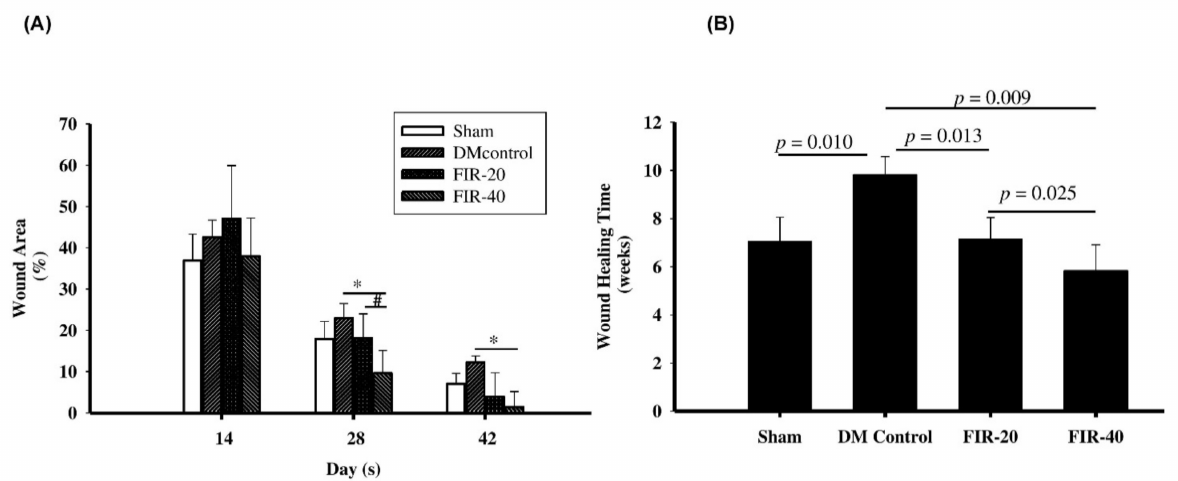
Figure 1. Far-infrared radiation (FIR) treatment in enhancing blood perfusion in the diabetic wound area. The blood perfusion in the wound area was detected by laser Doppler before (pre-FIR) and 1 h after the FIR (post-FIR) at the early and the late stage of treatment. ( A ) The initial blood flow in wounds was 365.38 ± 132.14 PU/wound for FIR 20 and 308.25 ± 82.99 PU/wound for FIR 40 on Day 4, which was set as 100%. ( B ) Upper: Laser Doppler Imager before (Pre-FIR) and after FIR treatment (Post-FIR). Lower: The change of blood flow was calculated by the expression (PostFIR − PreFIR)/PreFIR × 100% after FIR 20 and 40 min treatment respectively. The FIR-40 group showed a significant increase in wound area perfusion at the late phase after the FIR, * p < 0.05.